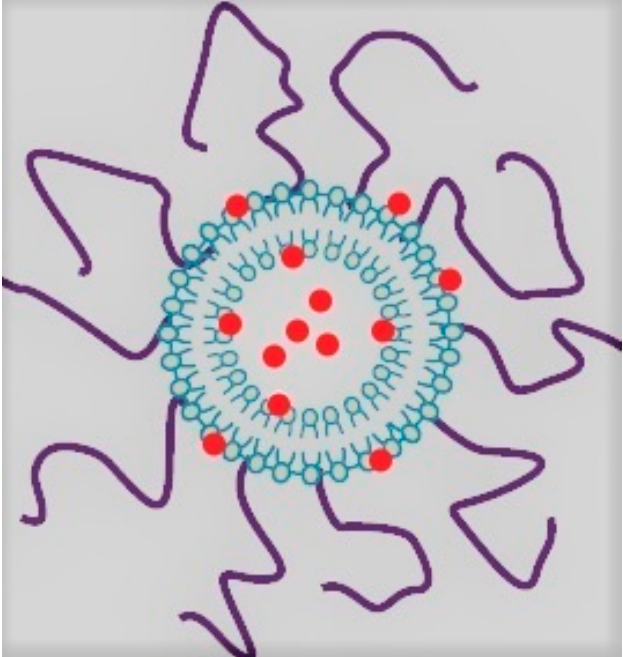
Figure 1. Liposomal nanoparticle-based blood-pool gadolinium contrast agent structure. Low molecular-weight gadolinium-chelated (in red) is inserted, both core-encapsulated and surface-conjugated, in liposome structures made of phospholipid bilayer (in light blue). The liposomes are also coated with PEG (in purple) and thus avoid penetration through placental barrier.